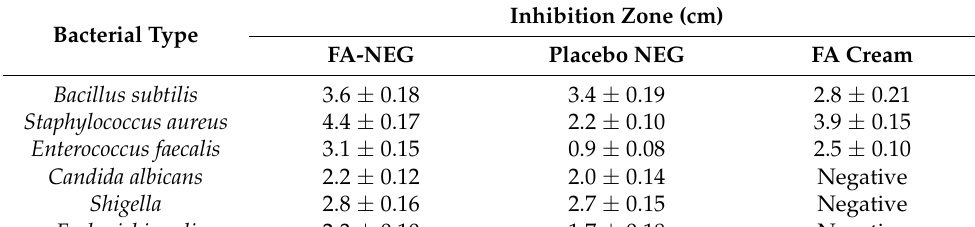
Table 8. Microbiological activity of the tested formulations against various organisms.